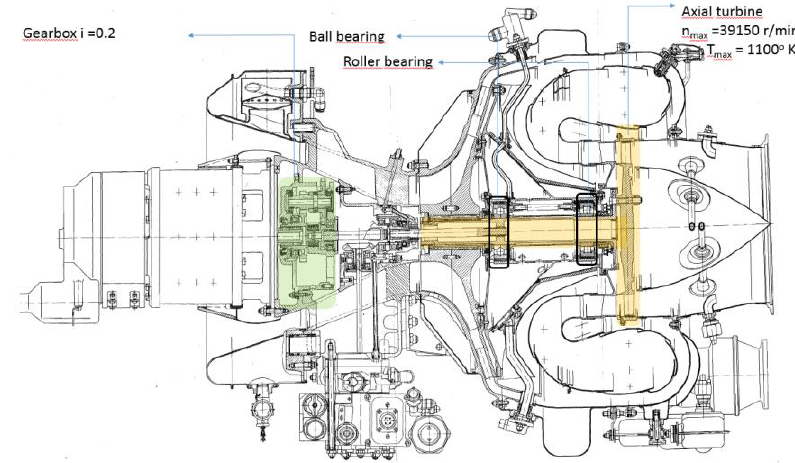
Figure 5. Cross-section of the AI-9W engine (Adapted from [20]).